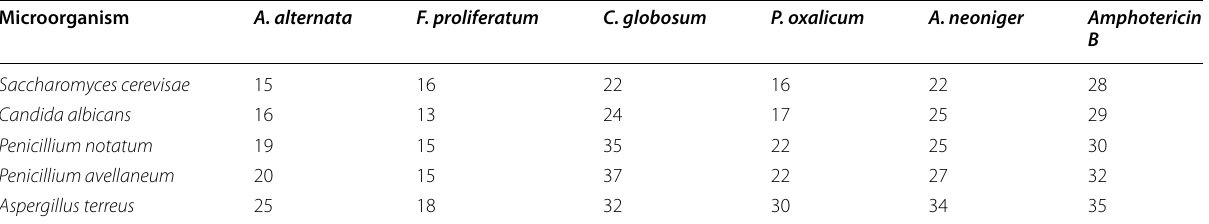
Antifungal activity is measured in terms of the diameter of the inhibition zone in millimeters